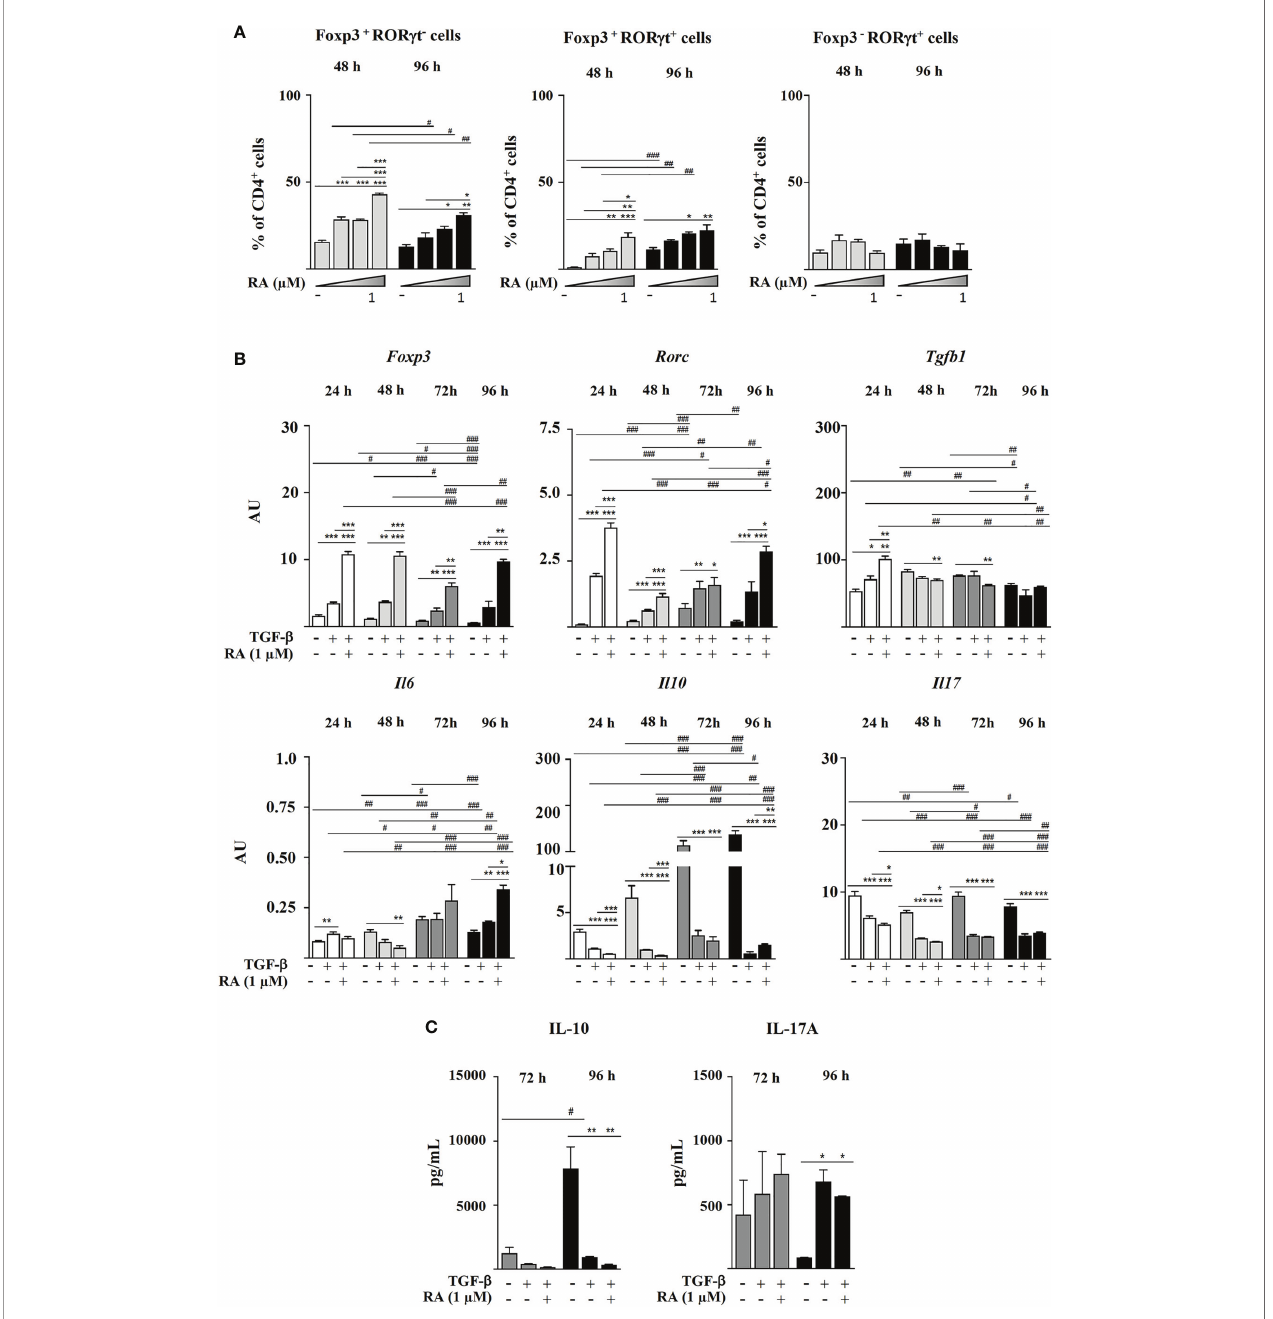
FIGURE 2 | Magnetic sorted CD4 + CD25 - spleen cells from BALB/c mice were stimulated with plate-bound anti-CD3 and soluble anti-CD28 in the presence of IL-2 (20 ng mL -1 ), TGF- b (5 ng mL -1 ), and RA (0.01, 0.1 or 1.0 m M). (A) Percentage of Foxp3 + , ROR g t + , Foxp3 + ROR g t - , Foxp3 + ROR g t + , and Foxp3 - ROR g t + cells within the total CD4 + T cell population at different time points. (B) Gene expression of Foxp3, Rorc, Tgfb1, Il6, Il10 , and Il17 , normalized to the reference gene Actb and expressed in arbitrary units (AU). (C) Secretion of IL-10 and IL-17A. Data are means of three different experiments (each performed with cells sorted from polled spleens from 3-5 mice) ± SEM (n = 3). * P < 0.05, ** P < 0.01, *** P < 0.001 indicate statistically signi fi cant differences between culture conditions at each time point assessed by one-way ANOVA followed by Tukey post-hoc test, and # P < 0.05, ## P < 0.01, ### P < 0.001 indicate statistically signi fi cant differences between